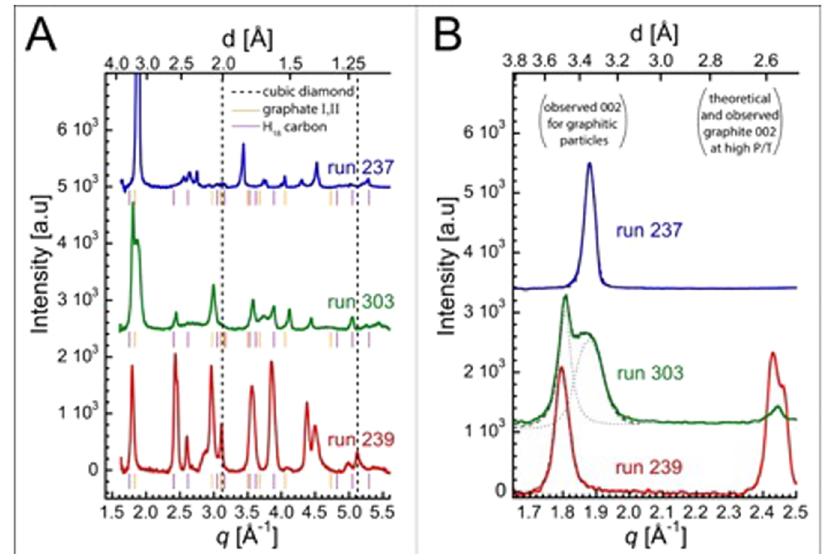
Fig. 4 Diffraction patterns (in arbitrary units) of solid products formed from shocked benzene at 55 GPa, 4940 K. A Expanded region between d = 2.5 and 3.8 Å shows the measured low-angle peaks (solid lines) and fi ts (dashed lines) relative to the estimated range of d -spacings for graphitic layered carbon structures at the same P – T conditions (gray shaded region) and the range of predicted d-spacings for graphate I – IV and H 18 at 50 GPa and ambient T (red shaded region). B Full range of the measured diffraction exhibiting multiple peaks that do not index to graphite or diamond forms, particularly in the regions of 2.4 – 2.8 and 3.4 – 3.6 Å − 1 . Dotted lines correspond to estimated graphite re fl ections, dashed lines to cubic diamond re fl ections at 55 GPa and 5000K. Calculated diffraction patterns for graphate-I, and -II from Wen et al. 46 , and H 18 calculated at 50 GPa and ambient T are shown for comparison 47 .